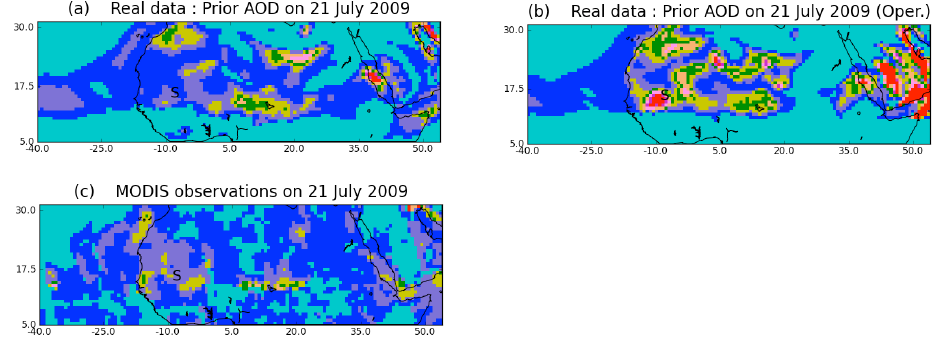
Fig. 11. Mean AOD estimates on 21 July 2009 at 12:00Z. See the colorbar in Fig. 10. (a) and (b) are the forecasts launched from the tuned and operational posteriors on 20 July, respectively. (c) Satellite data. Figure 11 : Mean AOD estimates on 21 July 2009 at 12:00 Z. See the colorbar in Figure 10.